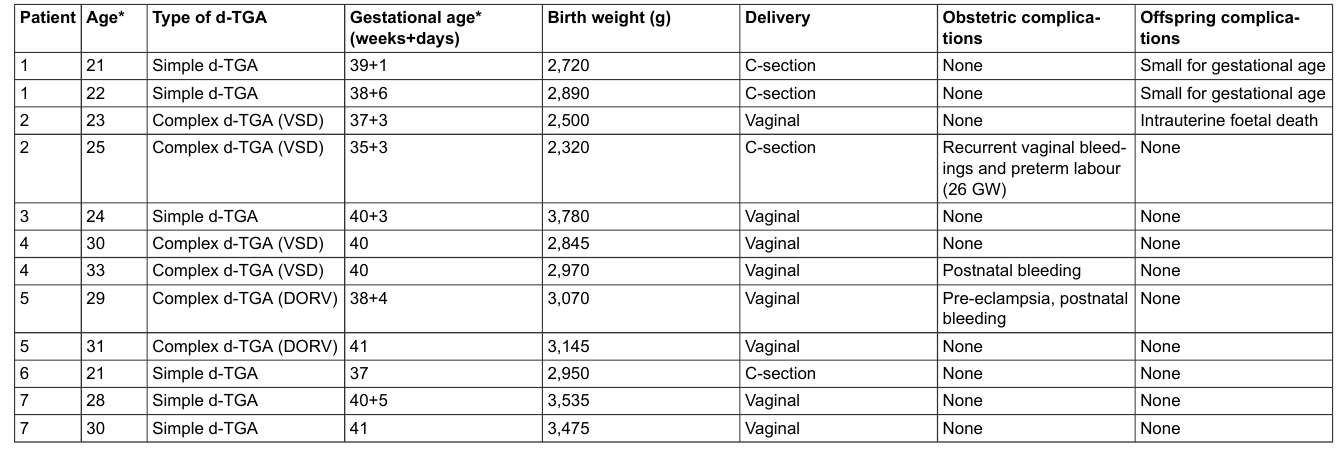
Table 4: Completed pregnancies. Patient